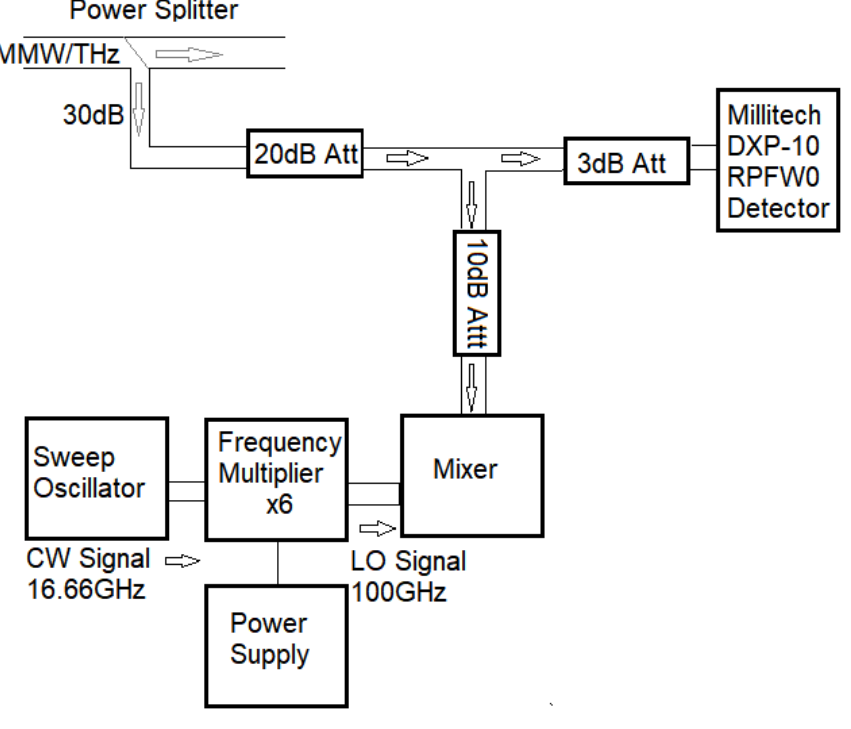
Figure 2. Schematic of frequency chirp measurements. An H-plane T junction was used in the setup in order to split the sampled signal for simultaneous power and frequency measurements (see Figure 2). A continuous wave signal from the sweep oscillator was arbitrarily chosen to be 16.667 GHz. This was then transformed by the multiplier into a local oscillator signal of 100 GHz. To measure and record the detected signal, the output signal of the mixer and the three detectors, they were directly connected to an